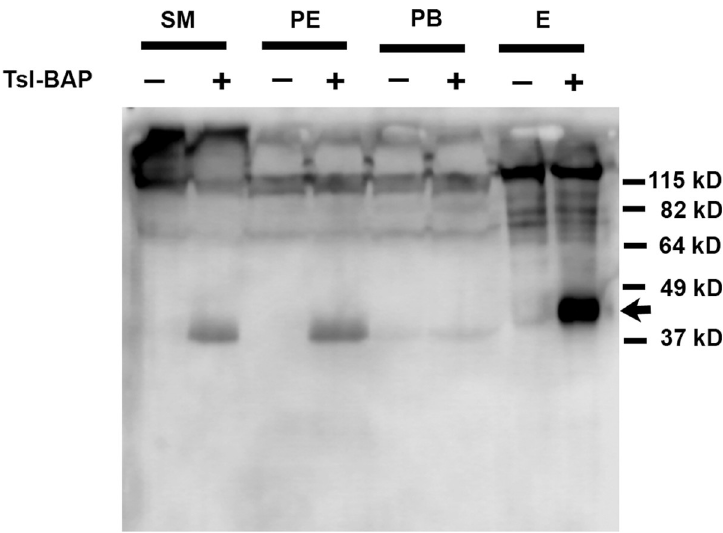
Fig 7. Tsl-BAP can be isolated from extracts using streptavidin-coupled resin. A procedure to isolate biotinylated proteins was carried out using extracts from embryos derived from females expressing secBirA and Tsl-BAP in the follicle cell layer (+), or from sibling females carrying only the secBirA transgene (-). The samples shown are the starting material (SM), the post-equilibration sample (PE), the post-binding supernatant (PB) after incubation with streptavidin resin, and the sample eluted (E) from the resin after extensive washing steps. The samples were subjected to SDS-PAGE, blotted and processed for biotin detection. 100 μ g of protein were loaded onto the SM, PE and PB lanes. For the eluate lanes, 2 μ l of a total volume of approximately 50 μ l was loaded. Biotinylated Tsl-BAP is detected in the SM and PE samples, but is absent from the PB samples, indicating that biotinylated Tsl-BAP was effectively removed from the mixture by the streptavidin